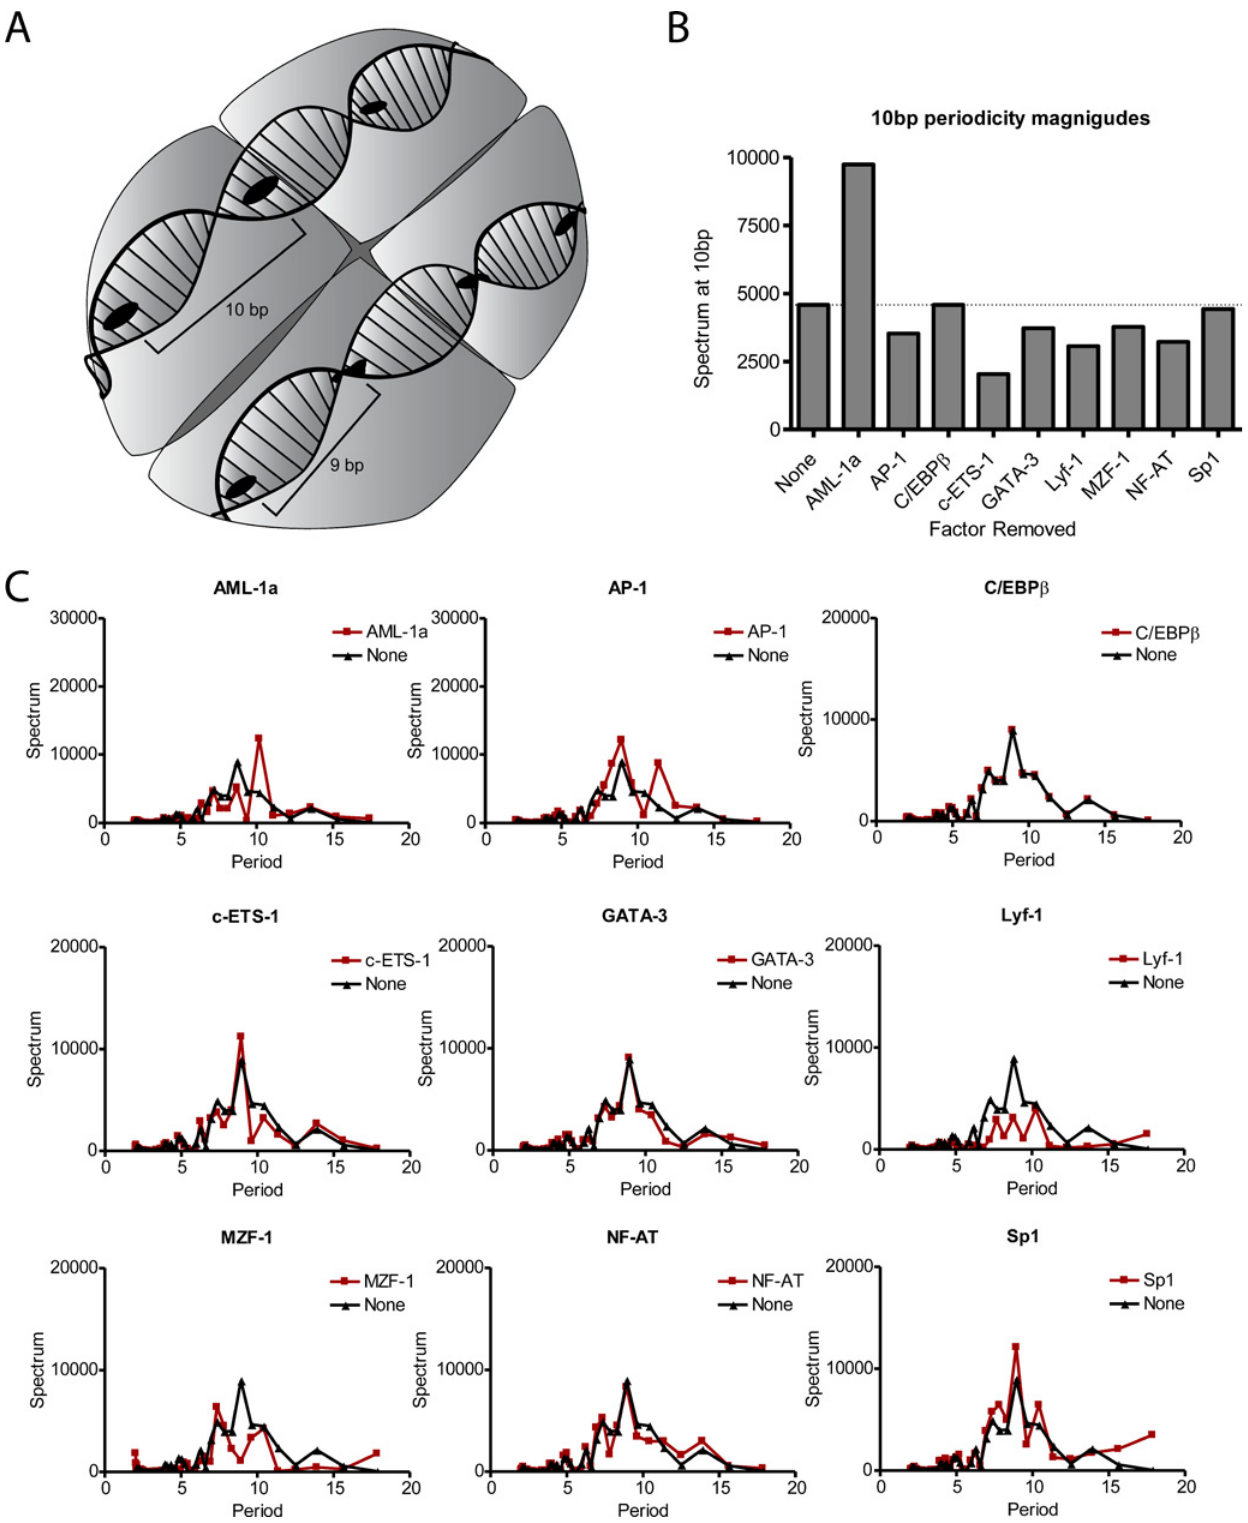
Fig 3. AML-1a specifically lacks 10 bp periodicity within the nucleosome-bound Ly49 regions. (A) Schematic showing the significance of 10 bp periodicity within a nucleosome-bound stretch of DNA. Those factor binding sites that display 10 bp periodicity can be oriented in such a way as to